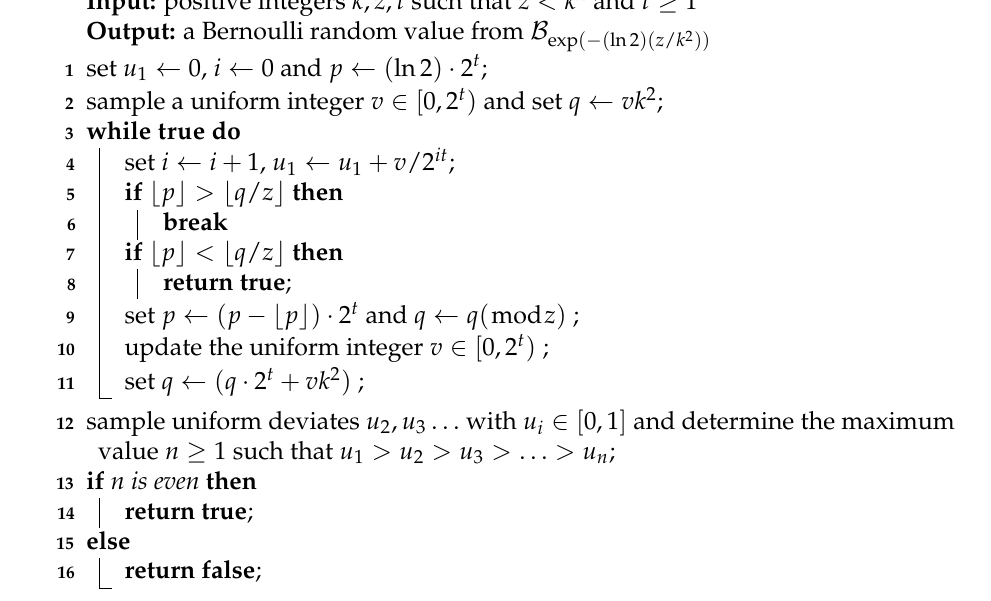
Algorithm 2: Sample from Bernoulli distribution B